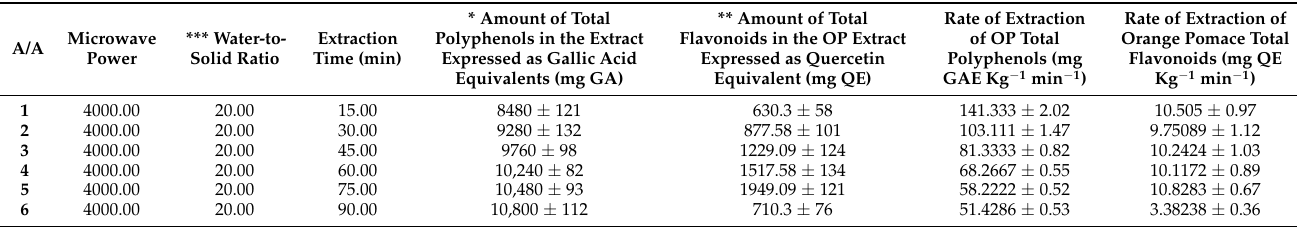
Table 1. Amount of total polyphenols and total flavonoids in raw orange pomace (OP) extracts and calculated productiv- ity